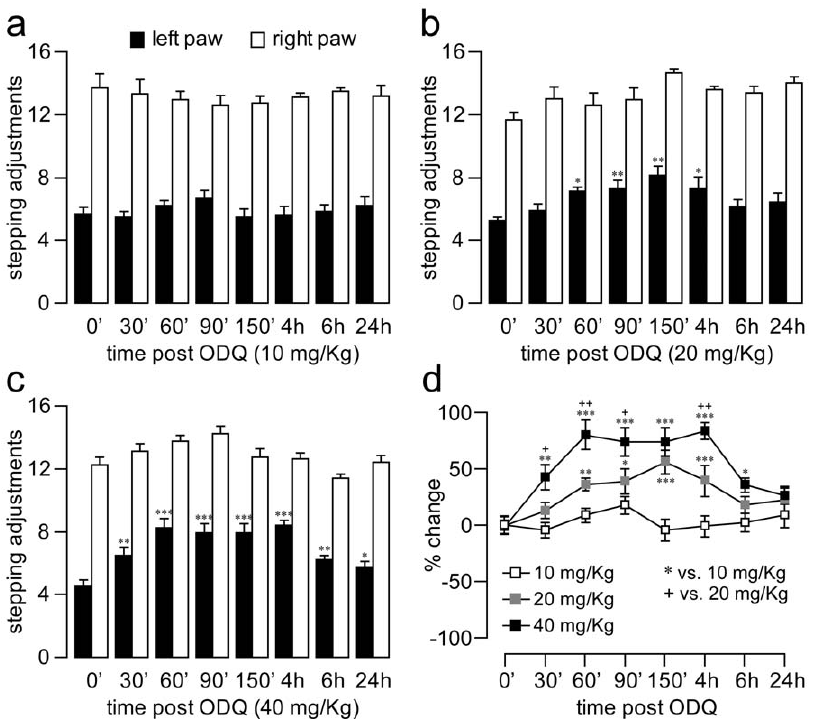
Figure 4. Dose dependent effects of ODQ on reducing forelimb stepping deficits observed in 6-OHDA-lesioned rats. ( a–c ) Bar graphs showing the effect of systemic ODQ administration (10, 20, 40 mg/kg, i.p.) on deficits in forelimb use in 6-OHDA lesioned rats assessed with the stepping test. ODQ treatment transiently attenuated stepping deficits observed in 6-OHDA lesioned rats in a dose-dependent manner (n=8 rats/ group; * P , 0.05 , ** P , 0.005 , *** P , 0.0005 , compared to baseline or time 0, Tukey post-hoc test after significant two-way ANOVA). ( d ) Summary graph (% change to baseline or time 0) depicting the impact of ODQ administration (10, 20, 40 mg/kg, i.p.) on deficits in forelimb use observed in 6-OHDA lesioned rats (*, + P , 0.05 , **, ++ P , 0.005 , *** P , 0.0005 , compared to measures taken at identical time points as indicated, Tukey post-hoc test after significant two-way ANOVA).